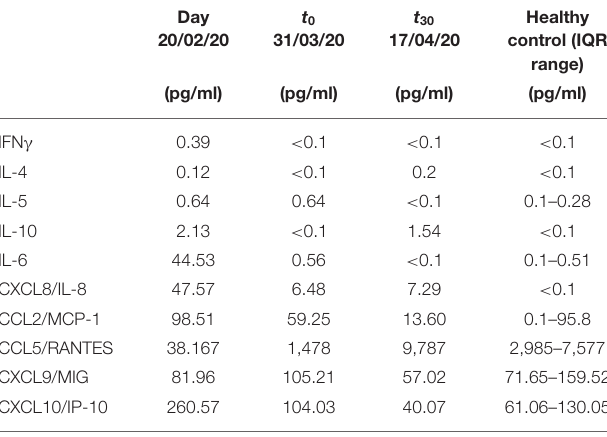
TABLE 2 | Chemokine and cytokine levels of the CF patient were analyzed before SARS-CoV-2 infection, at the time of hospital admission ( t 0 ) and 30 days after discharge ( t 30